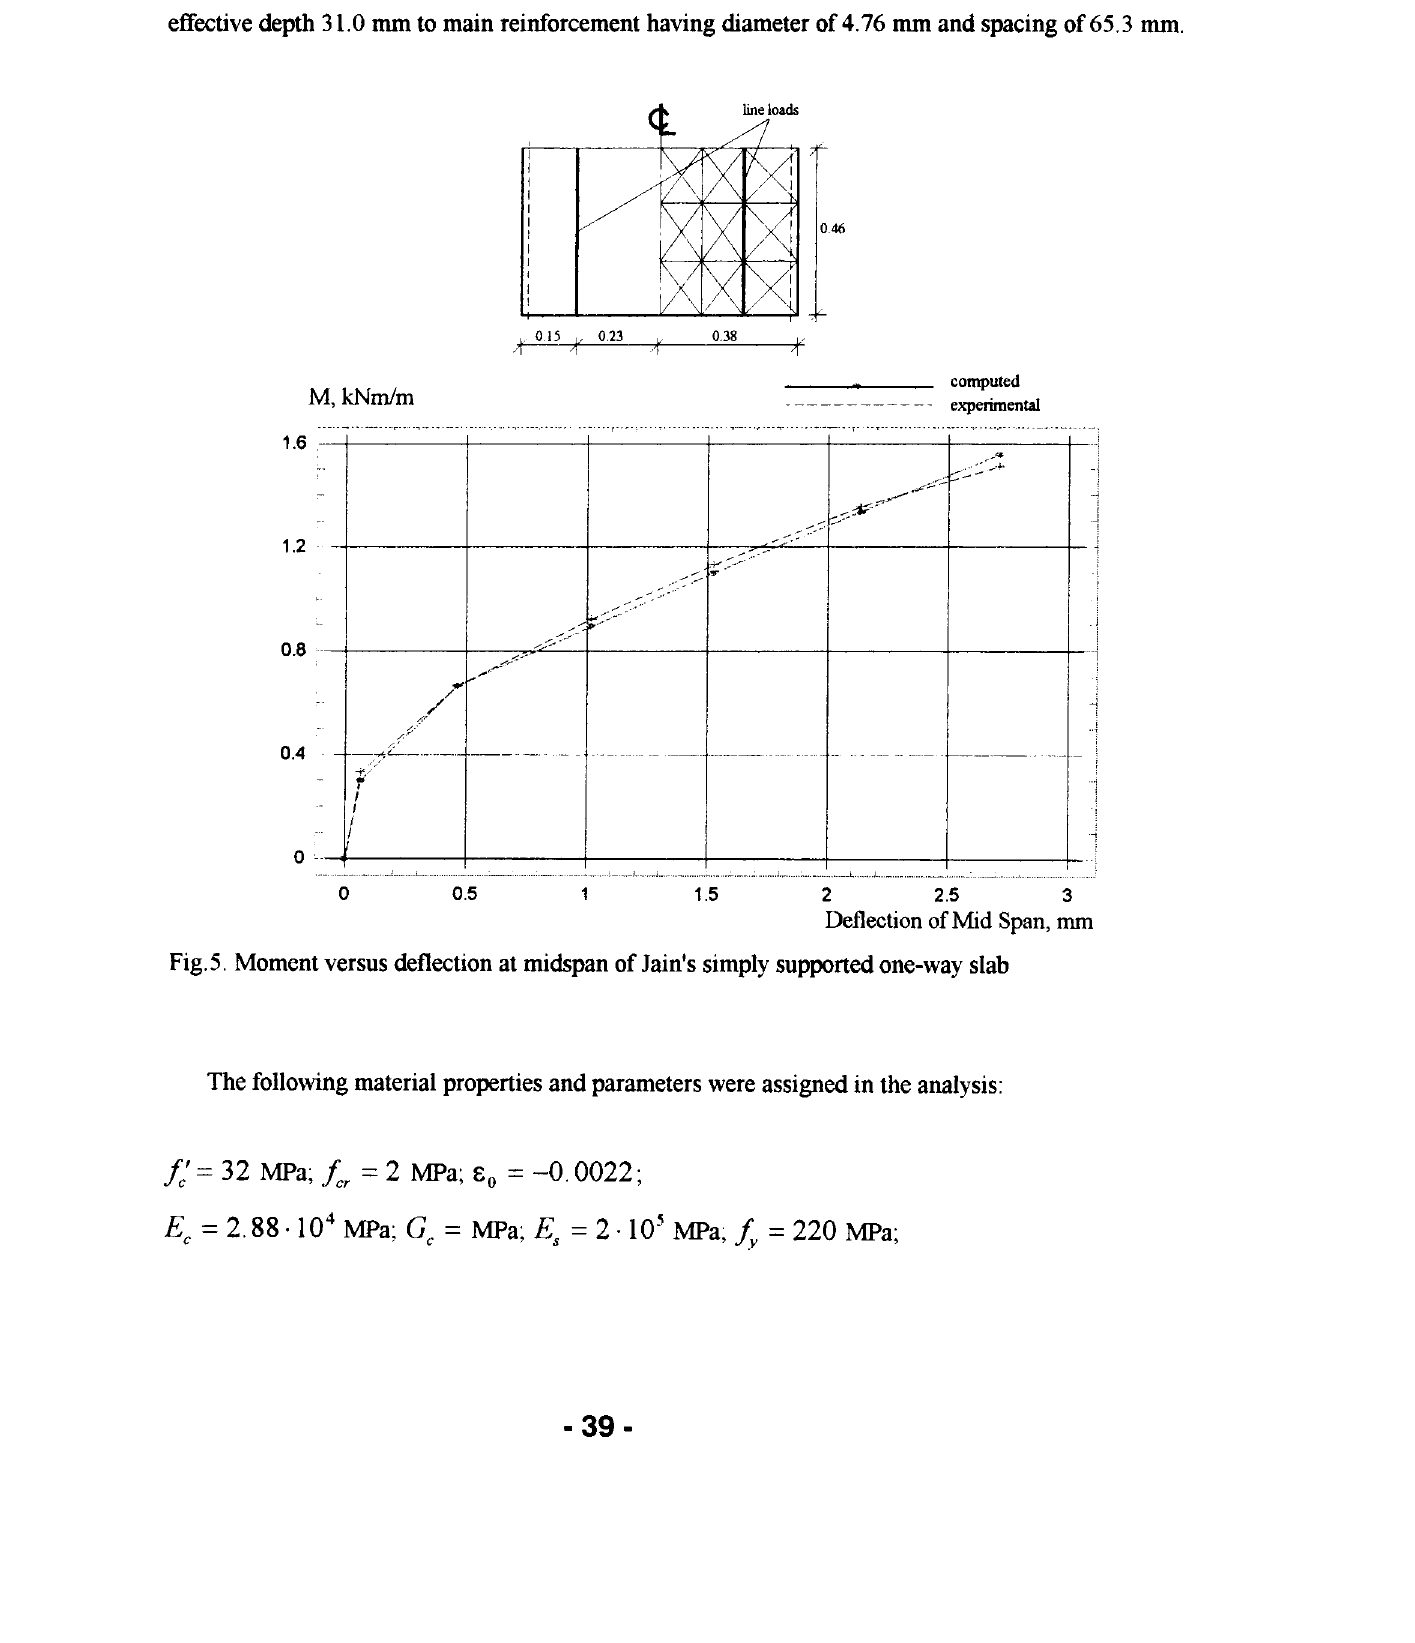
Fig.5. Moment versus deflection at midspan of Jain's simply supported one-way slab